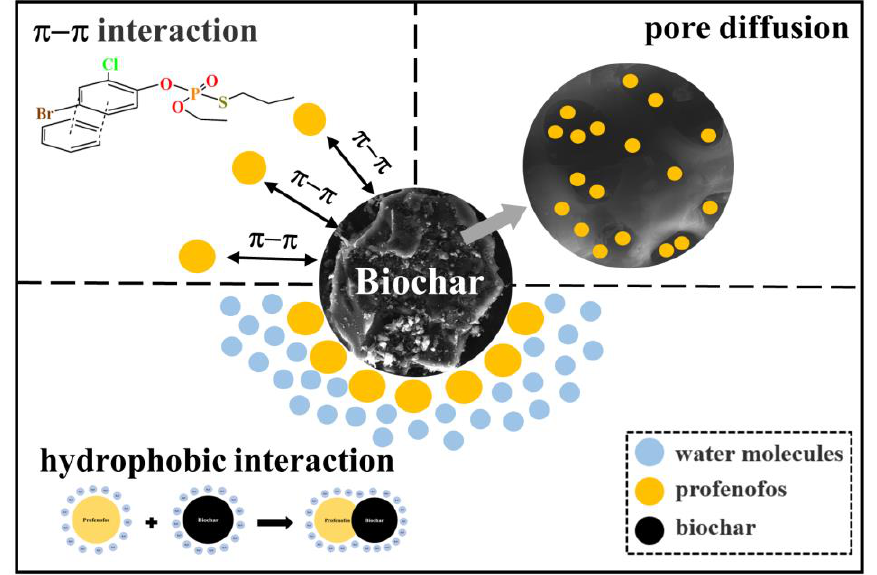
Figure 5. Proposed adsorption mechanism of nutshell biochars.